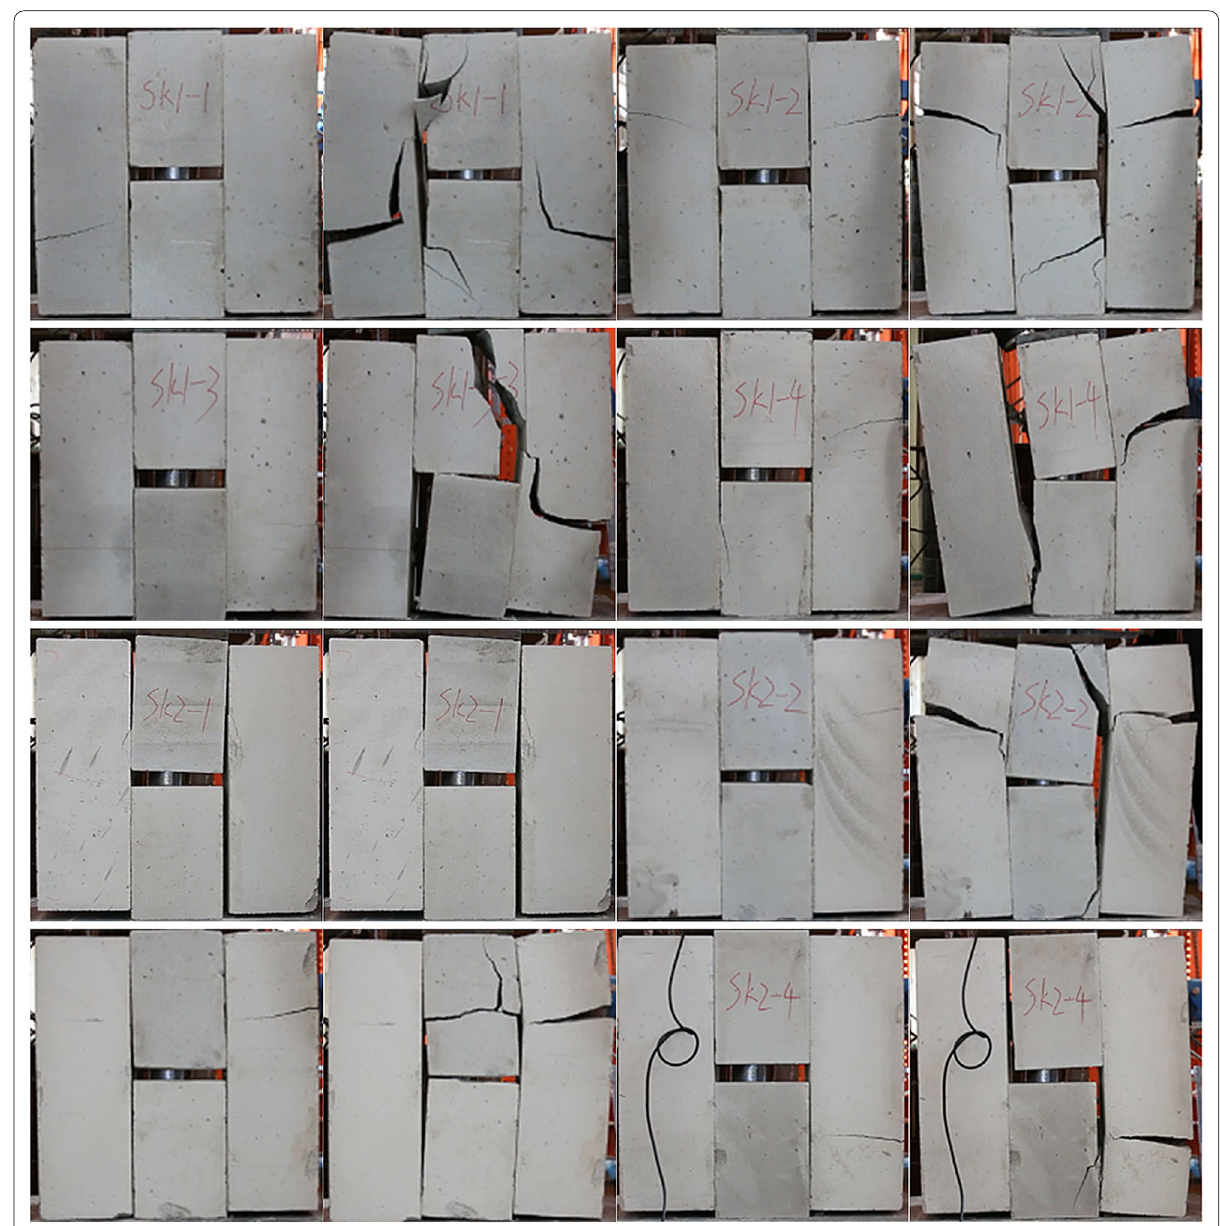
Fig. 10 Development and failure pattern of sheared